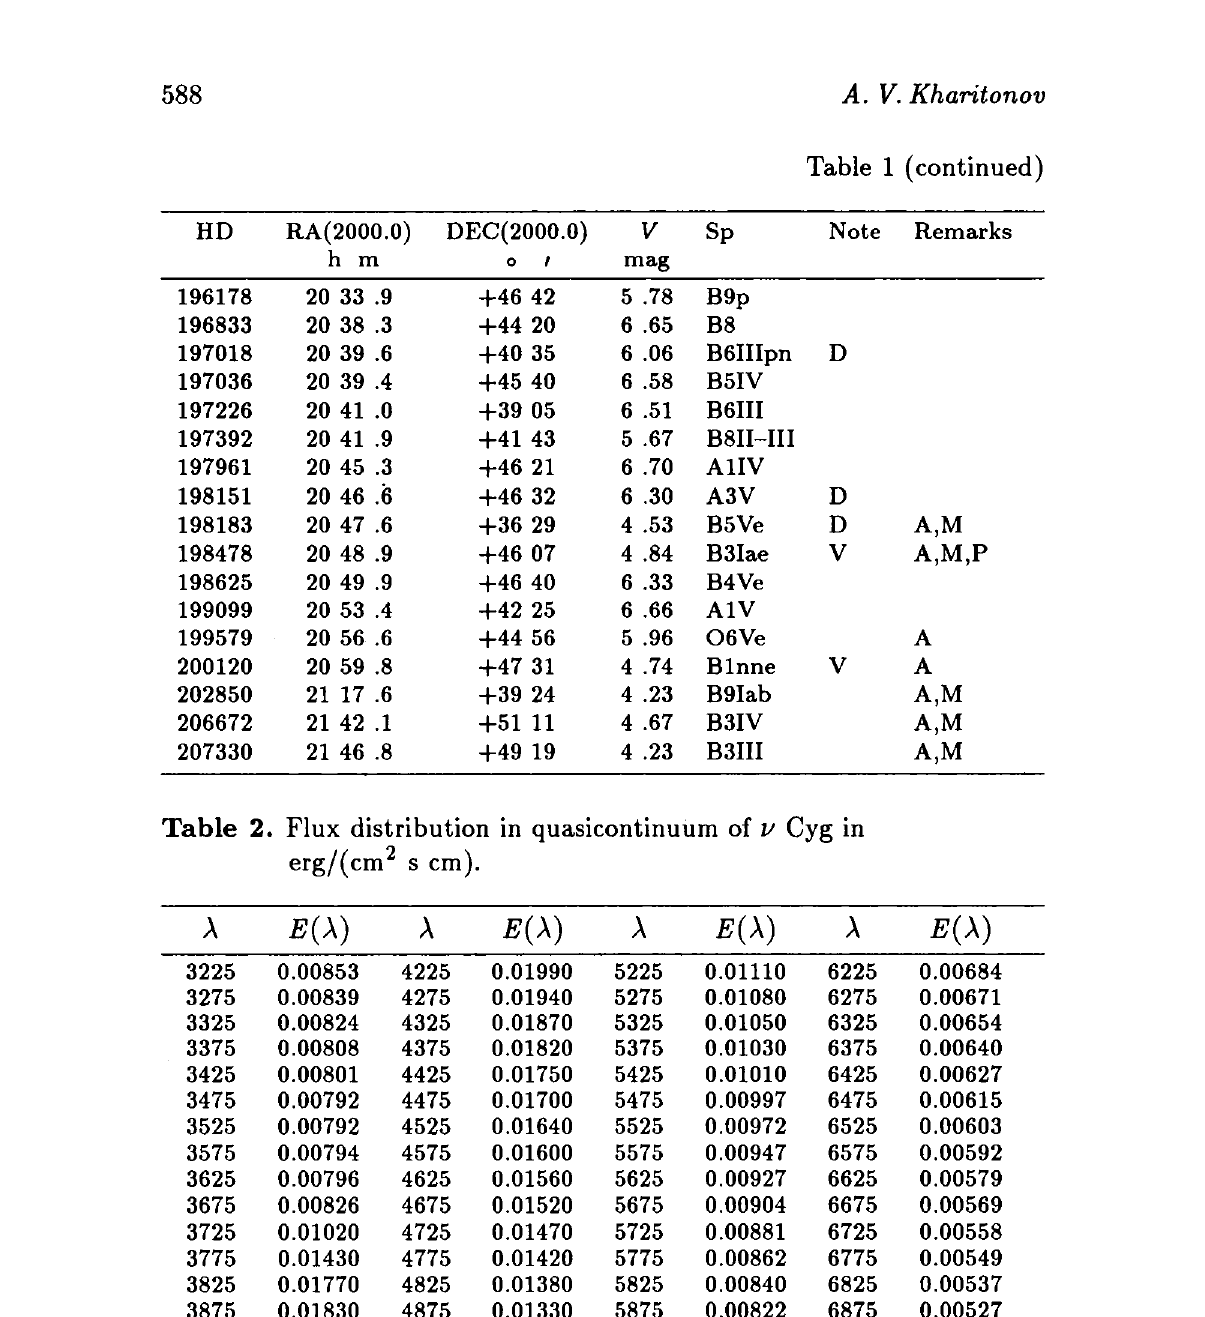
Table 2. Flux distribution in quasicontinuum of v Cyg in er g/( cm s cm